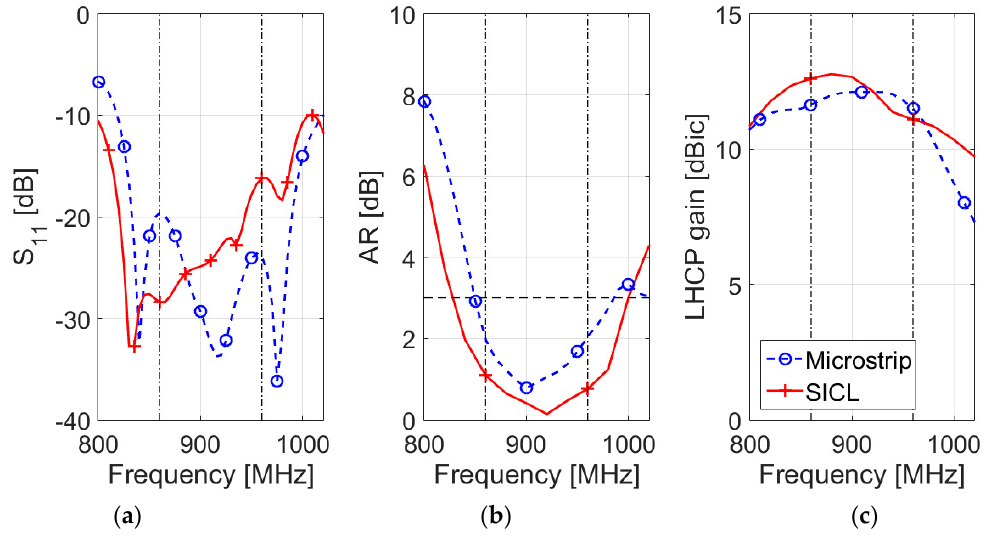
Figure 5. Simulated performance comparison of the antenna array with microstrip-based and SICL- based feed networks: ( a ) S 11 , ( b ) AR, and ( c ) LHCP broadside gain.